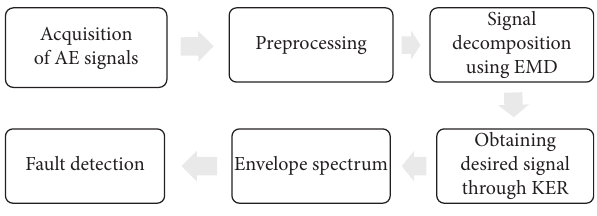
Figure 1: Process of the method.